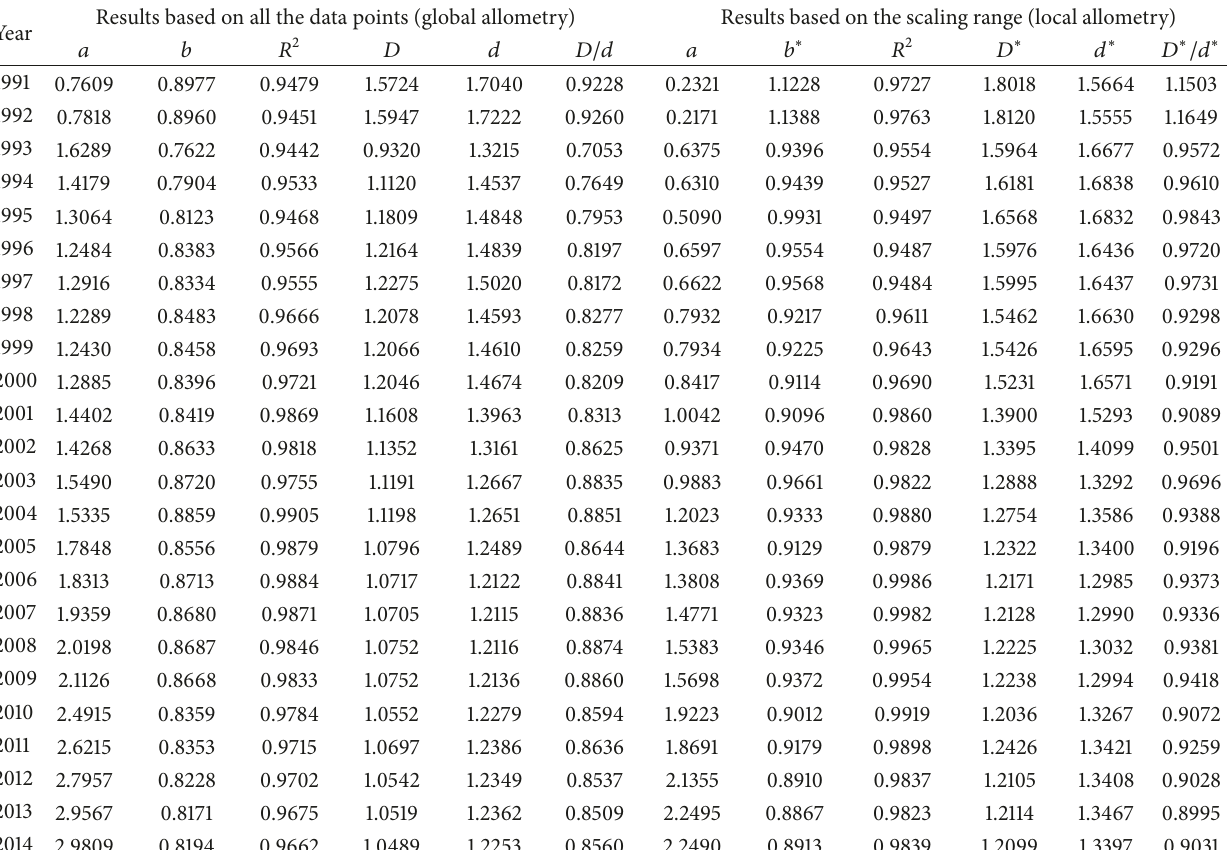
Table 2: The global and local allometric and fractal parameters of the hierarchies of Chinese cities (1991–2014). Results based on all the data points (global allometry) Results based on the scaling range (local Year